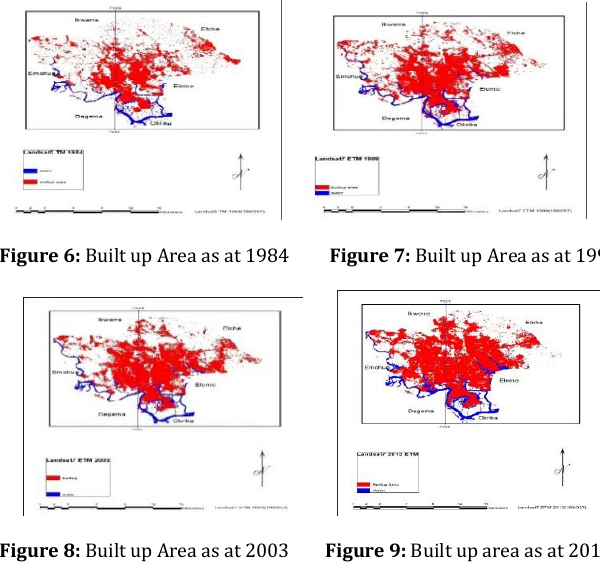
Figure 8: Built up Area as at 2003 Figure 9: Built up area as at